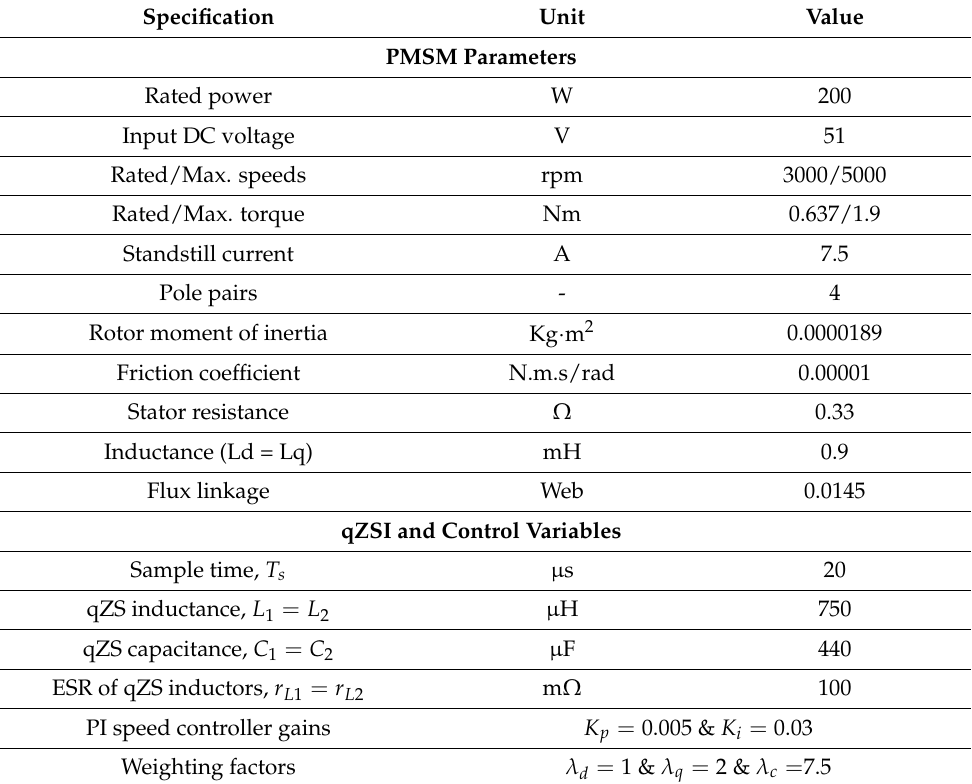
Table 3. Simulation parameters and